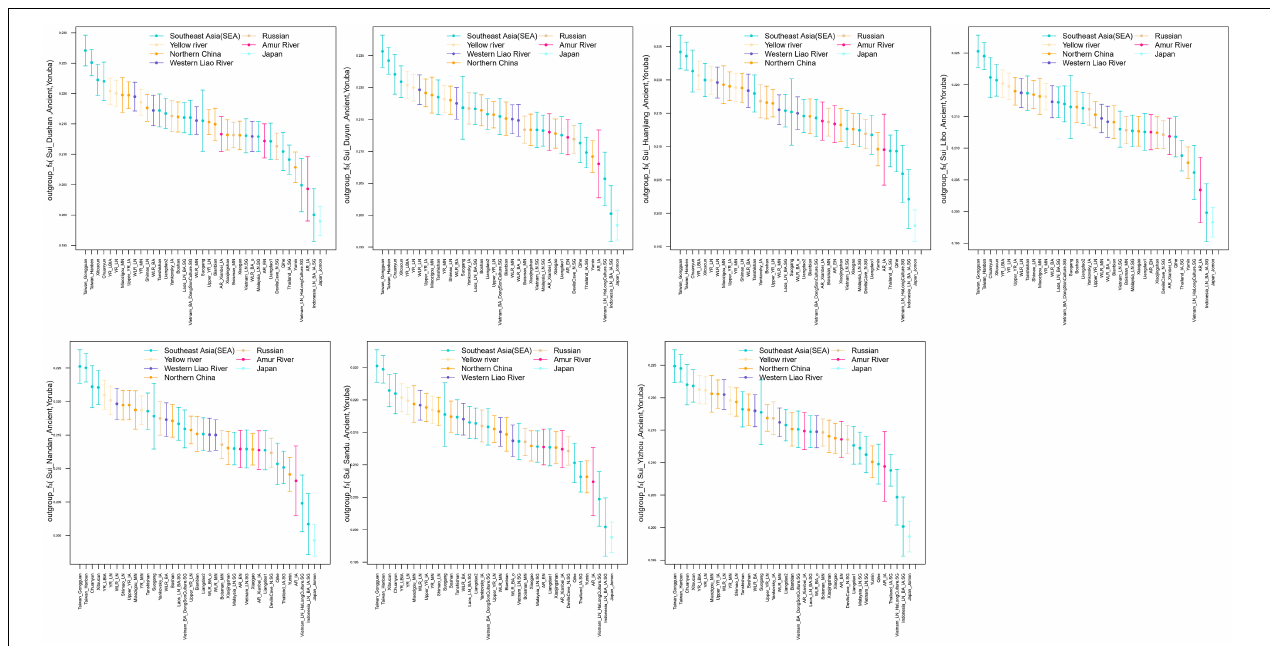
FIGURE 5 | Error bar plot showed the genetic affinity between studied Sui populations and ancient East Asians revealed by outgroup-f 3 (ancient reference East Asians, Studied Sui; Yoruba) . The error bar is marked as the standard